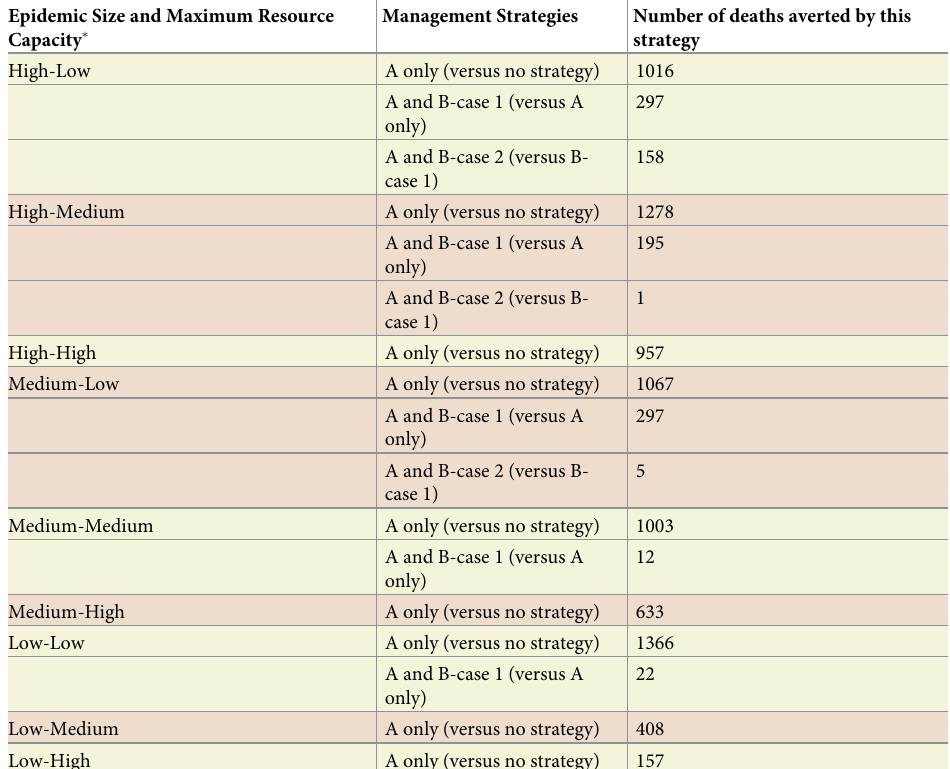
Table 4. Scenario analysis